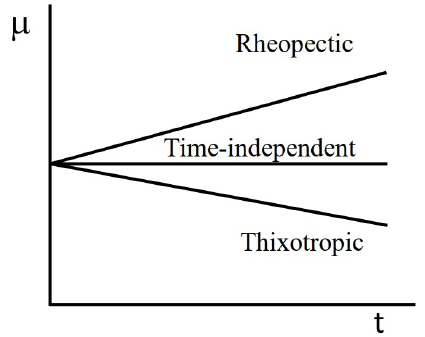
Figure 6: Typical curves of viscosity as a function of time at constant shear rate for thixotropic (positive thixotropy), rheopectic (negative thixotropy) and time-independent